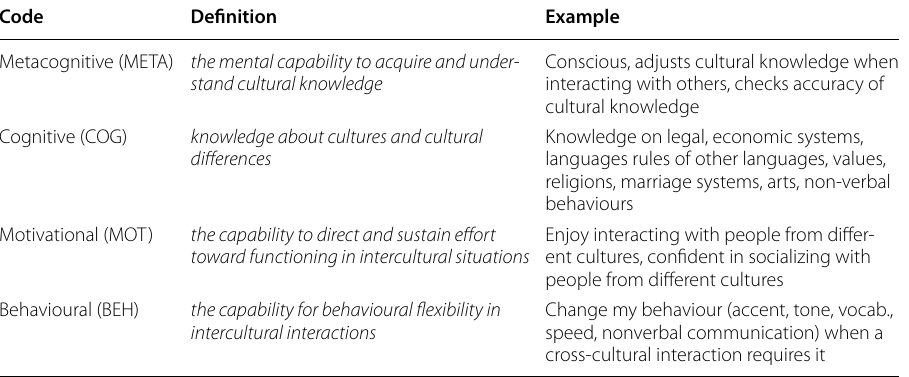
Table 2 Coding frame (based on CQS